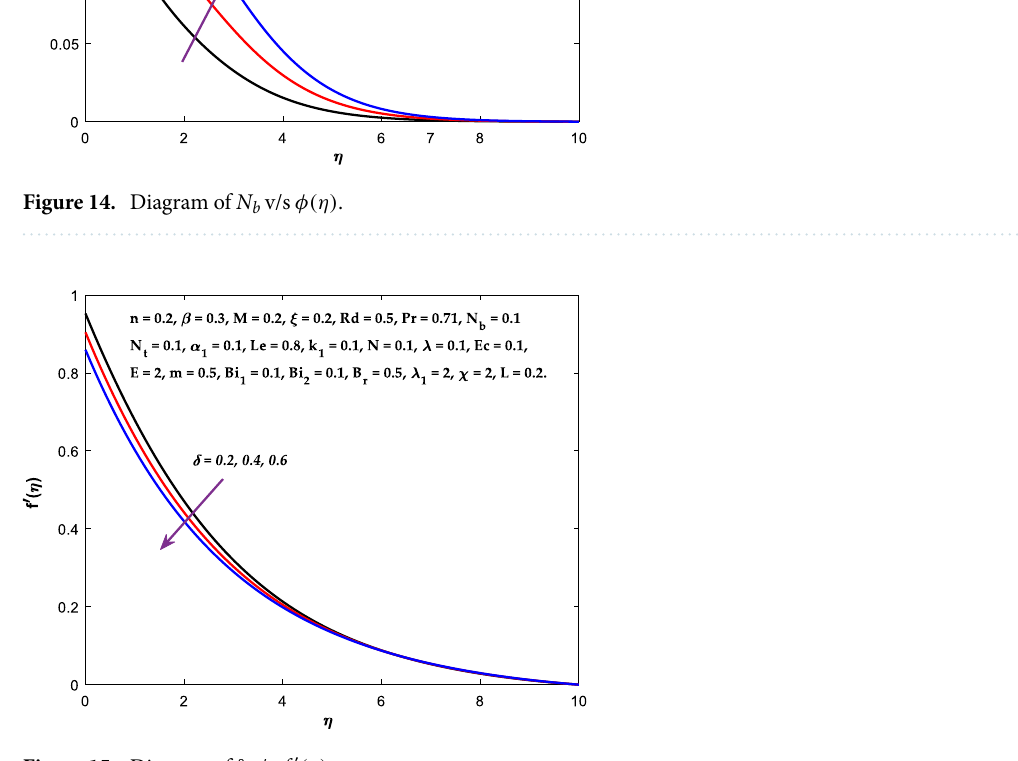
Figure 15. Diagram of δ v/s f ′ (η)